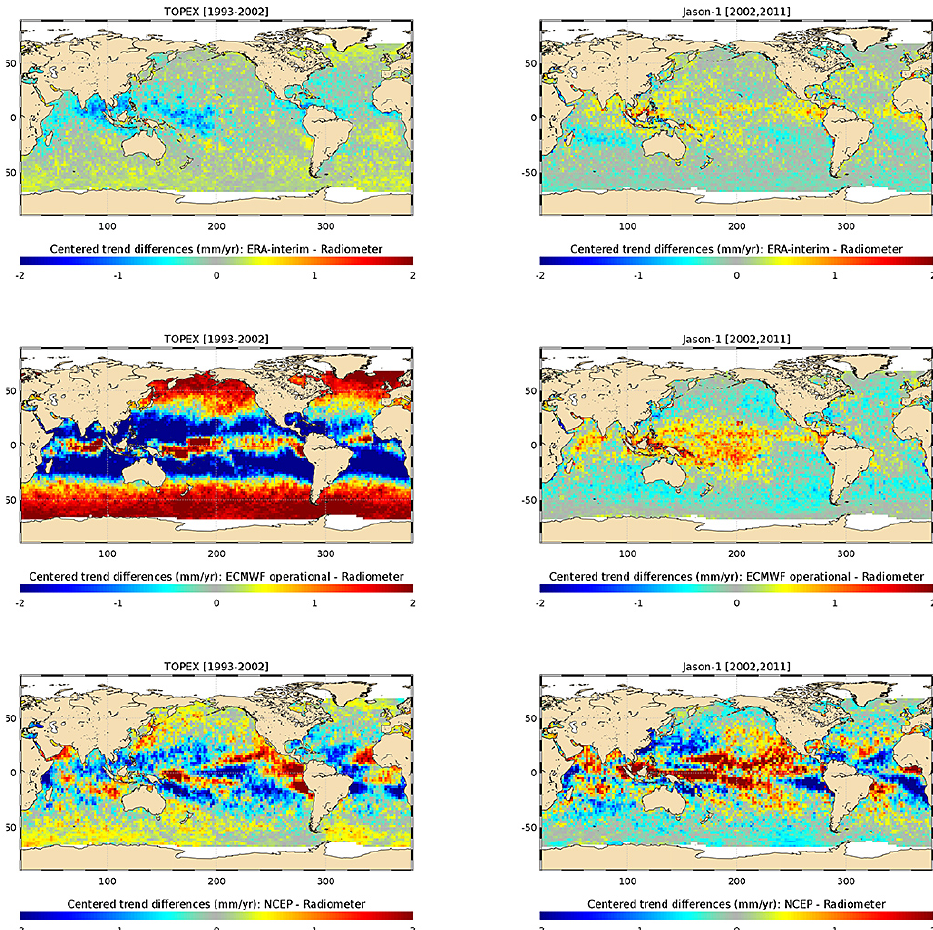
Figure 5. Map of the regional differences (centered on the mean, in mmyr − 1 ) between the trends of altimeter sea levels, successively corrected from modeled wet troposphere corrections and the radiometer corrections: ERA-Interim reanalysis (top), ECMWF operational (middle) and NCEP/NCAR reanalysis (bottom). Statistics have been computed over the first altimetry decade (from 1993 to 2002) with TOPEX data (left) and over the second altimetry decade (from 2002 to 2011) with Jason-1 data (right).